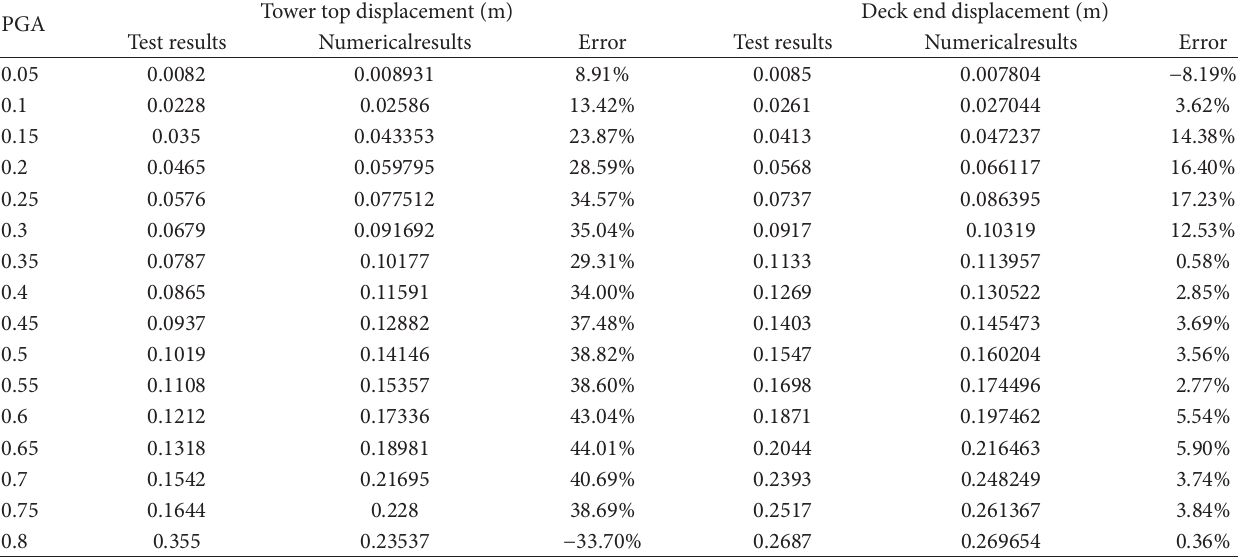
Table 7: Comparisons of maximum displacement between measured and numerical